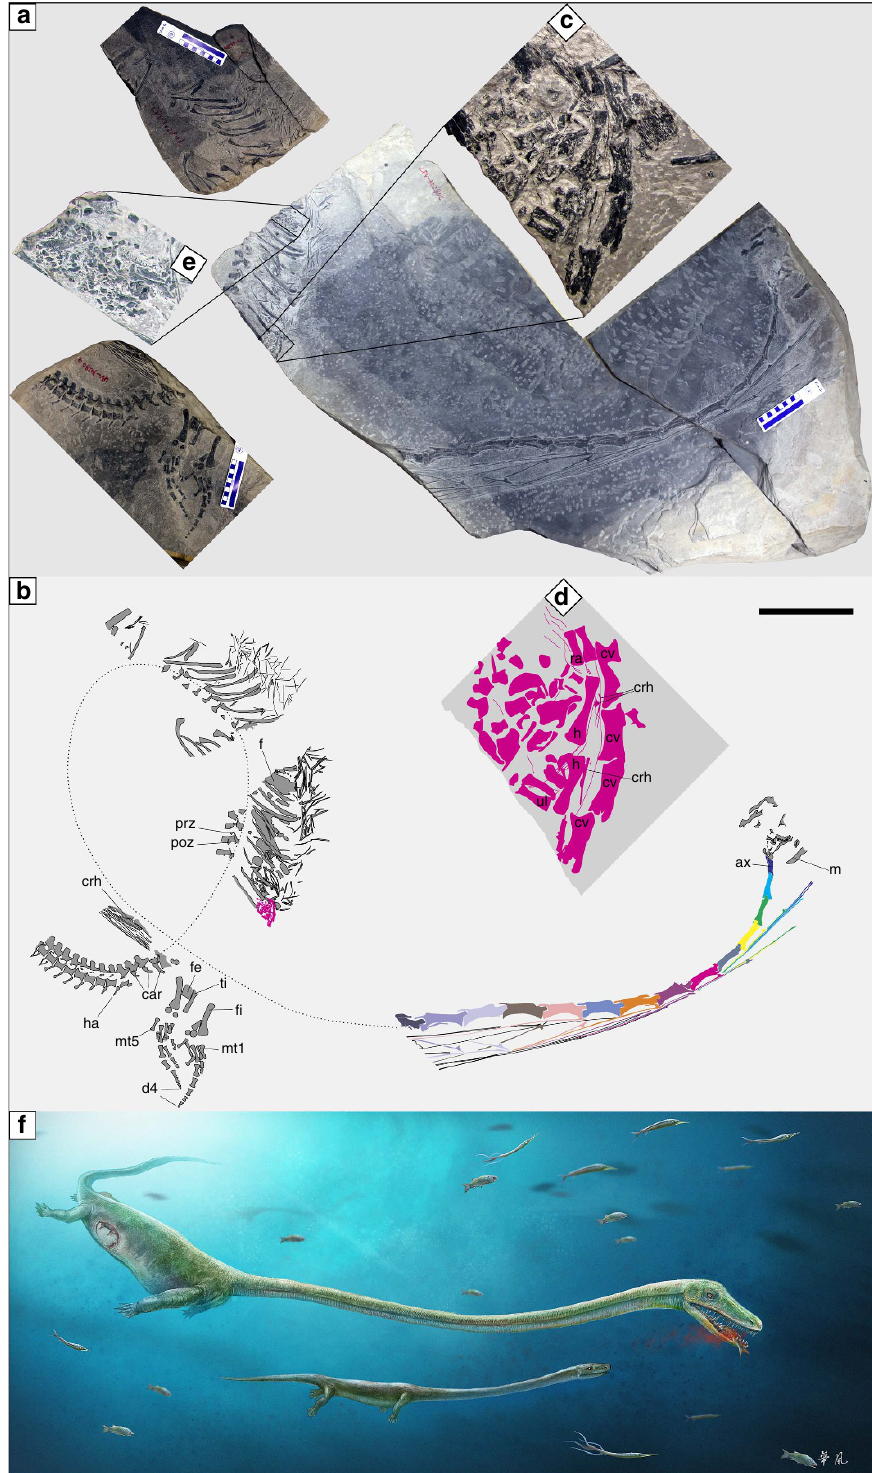
Figure 3 | Skeleton of the new Dinocephalosaurus specimen LPV 30280. ( a ) Photograph. The three separate blocks are arranged following their original positions in the field. ( b ) Interpretive drawing. Dotted line indicates the rough course of the vertebral column of the adult. The different colour in the cervical region aims to facilitate the association of cervical ribs with corresponding vertebrae. ( c ) Photo showing a close-up of the embryo preserved in the stomach region of LPV 30280. ( d ) Interpretive drawing of the embryo. ( e ) Photo showing a close-up of the perleidid fish preserved in the stomach region of LPV 30280. ( f ) Artist’s reconstruction of Dinocephalosaurus showing the rough position of the embryo within the mother. ax, axis; car, caudal rib; crh, cervical rib head; cv, cervical vertebrae; d4, fourth digit; f, perleidid fish; fe, femur; fi, fibula; h, humerus; ha, haemal arch; m, mandible; mt1, metatarsal 1; mt5, metatarsal 5; poz, postzygapophysis; prz, prezygapophysis; ra, radius; ti, tibia; ul, ulna. Scale bar,